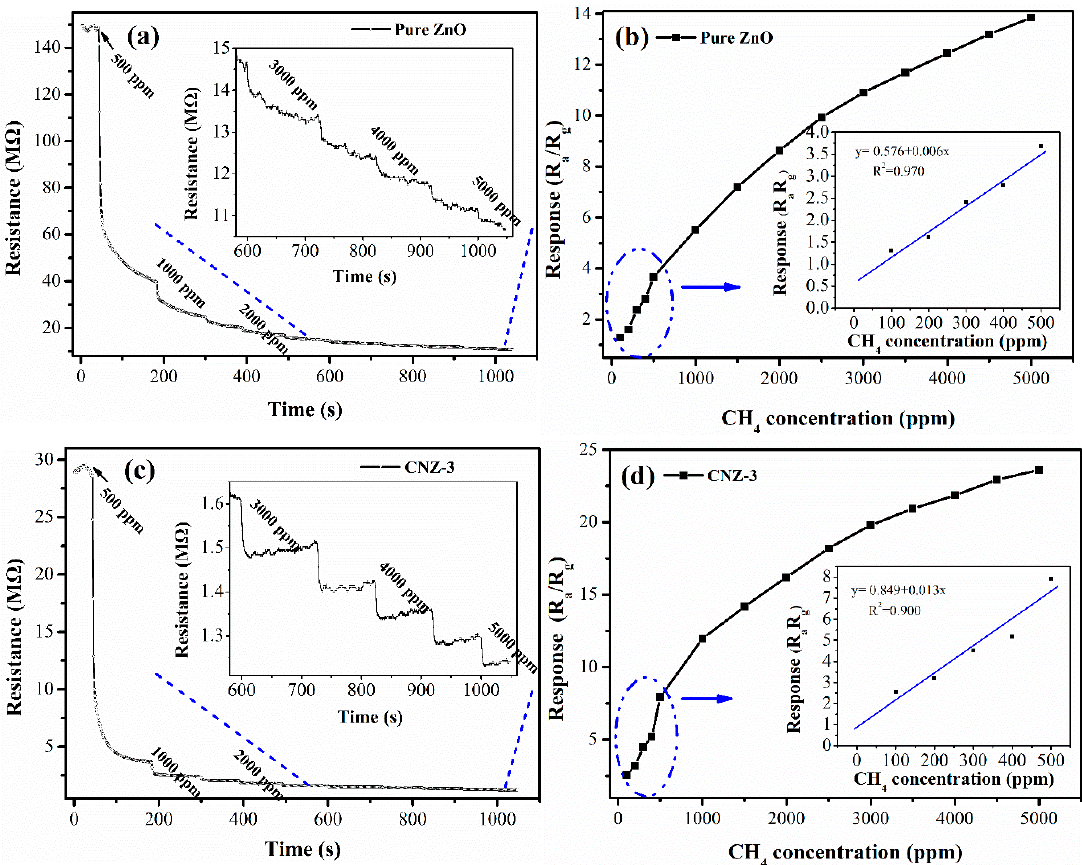
Figure 9. Dynamic electrical responses of the ( a ) ZnO and ( c ) CNZ-3 sensors with the CH 4 concentration increasing from 500 ppm to 5000 ppm at 320 °C; the concentration-dependent response curves of ( b ) ZnO and (d) CNZ-3.